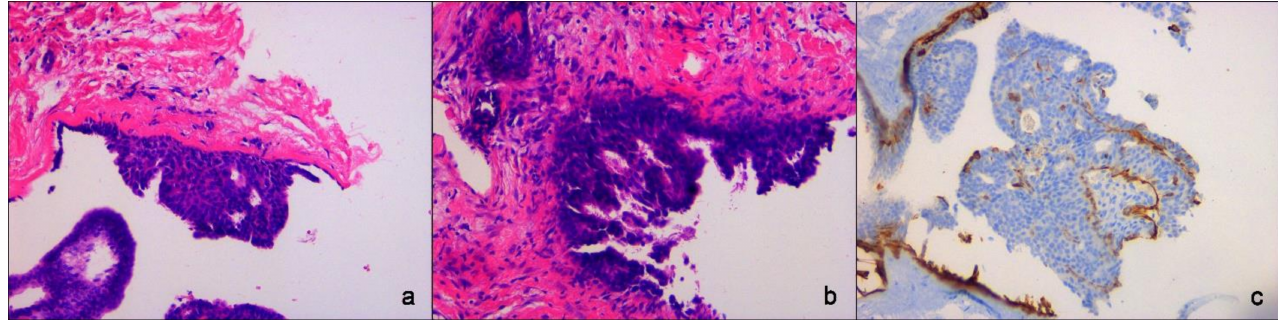
Figure 4. Core-Needle Biopsy sampling. ( a , b ) Atypical Ductal Hyperplasia (ADH) with true papillary projections. Hema- toxylin eosin stain, × 200 magnification. ( c ) Immunohistochemistry for p63 showing myoepithelial component, × 200 magnification.